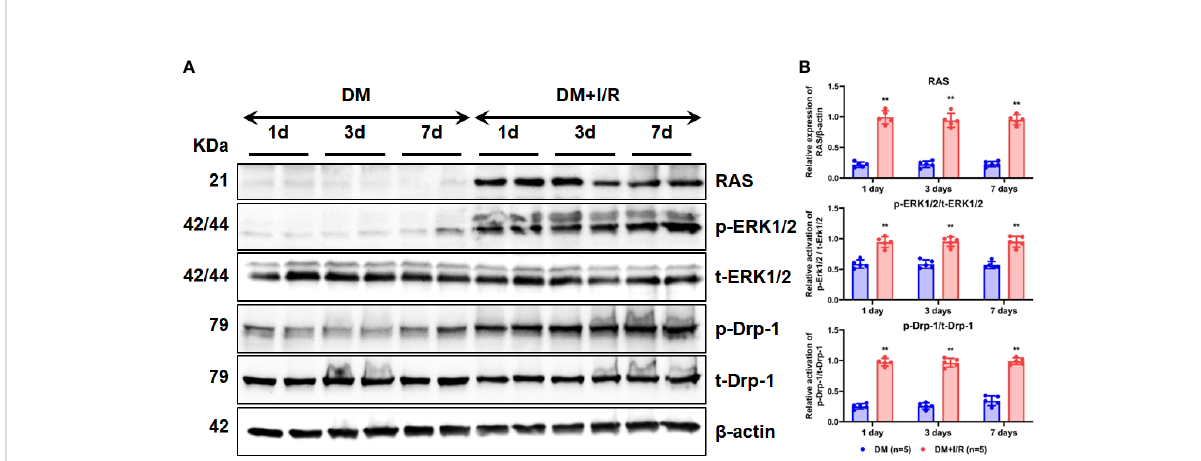
FIGURE 3 Activation of ERK1/2 pathway after cerebral I/R in diabetic rats. After I/R injury in diabetic rats, the expression and activation of RAS, ERK1/2, and Drp-1 in rat brain tissue on the 1 st , 3 rd , and 7 th day were detected by Western blot (A) , and gray values were determined by ImageJ (B) . In each group (n = 5), all the results are Mean ± SD, compared with DM group, **p < 0.01. DM, diabetes mellitus.